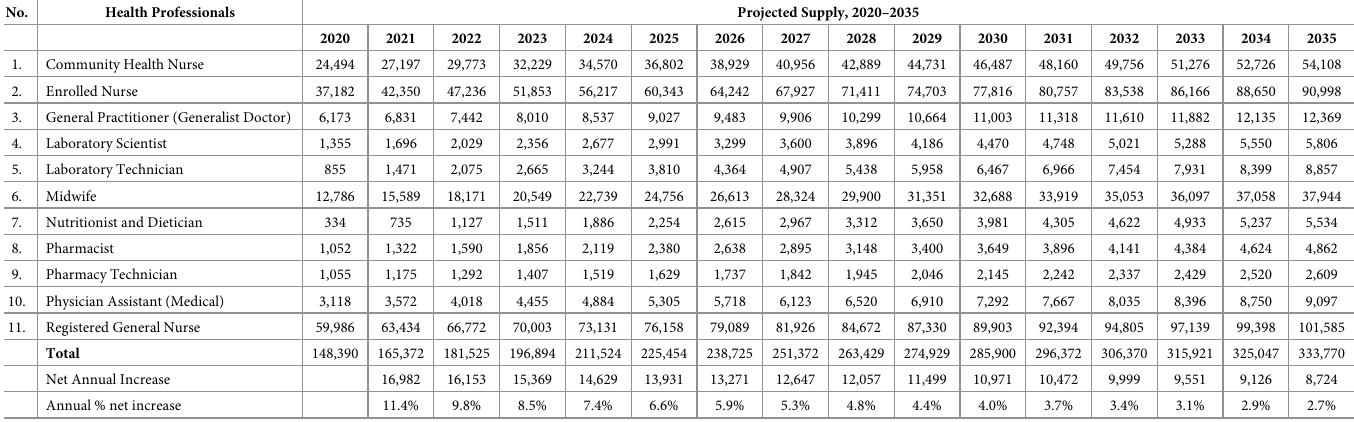
Table 2. Projected supply of health professionals,